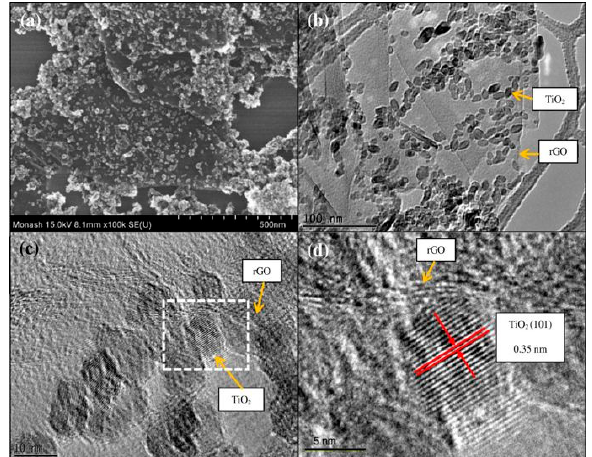
Figure 10. ( a ) Field-emission scanning electron image and ( b ) transmission electron micrograph of the solvothermally synthesized rGO / TiO 2 nanocomposite. ( c , d ) Enlarged images of high-resolution transmission electron micrographs showing the lattice fringes of TiO 2 and a clean interface between TiO 2 and rGO. Reproduced with permission from [146]. Copyright Springer, 2013.